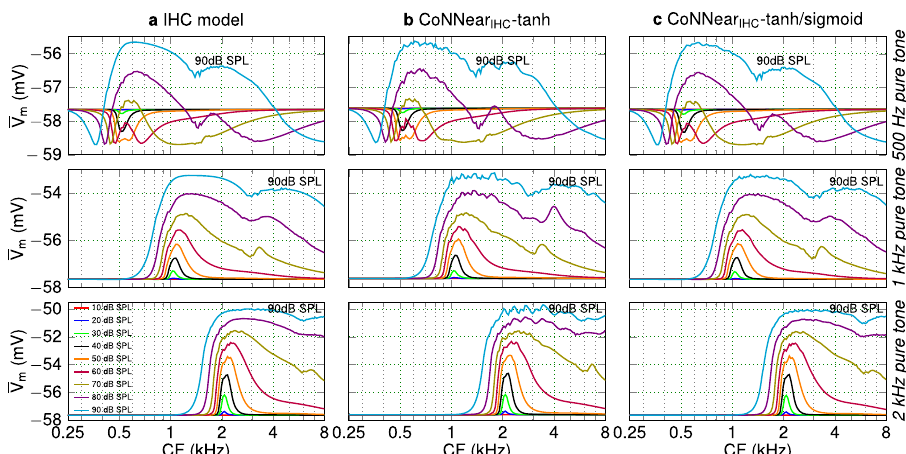
Fig. 2 Comparing IHC excitation patterns (Metric 1). Simulated average IHC receptor potentials V m across CF for tone stimuli, presented at levels between 10 and 90 dB SPL. From top to bottom, the stimulus tone frequencies were 500 Hz, 1 kHz, and 2